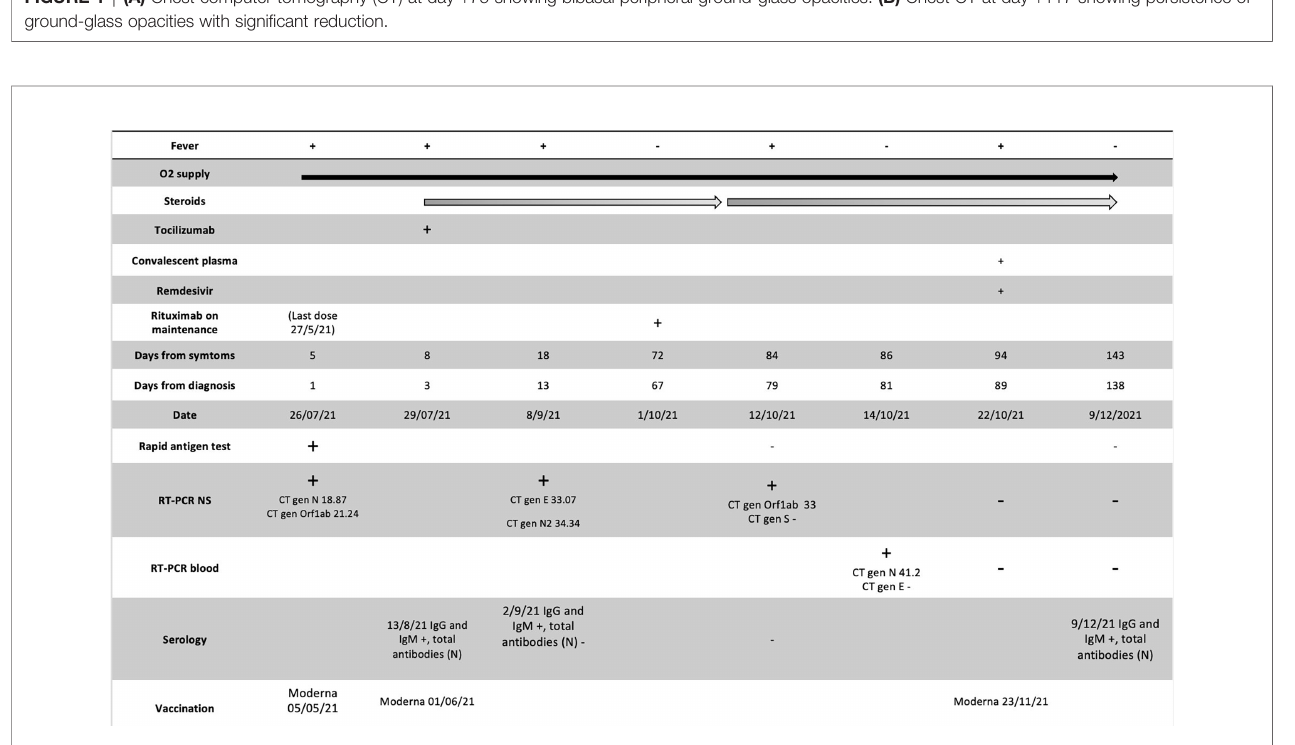
FIGURE 2 | A timeline of the case 1; administered treatments, O2 supply, Rituximab administration, serology, date of vaccination and diagnosis test [Rapid Antigen Test and RT-PCR in nasopharyngeal swabs (NS) and plasma]. RT-PCR, real-time polymerase chain reaction; CT, Cycle threshold values; N,